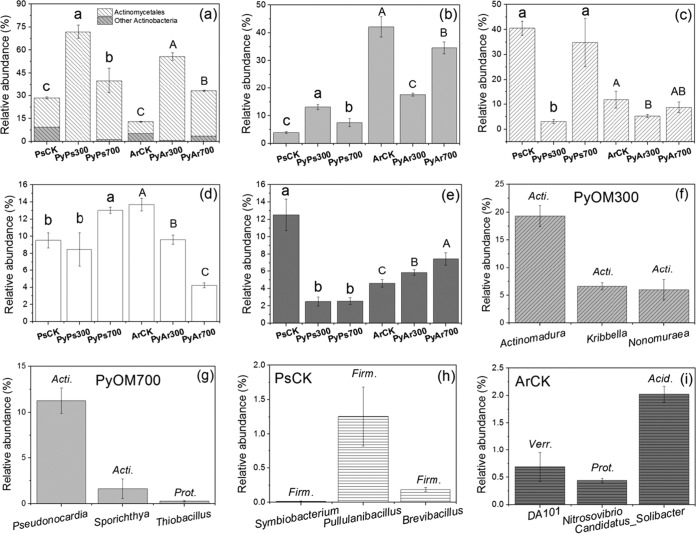
Relative abundances of dominant phyla in each treatment and indicator genera in PyOM300, PyOM700, and control soils. Values in Ps and Ar soil samples followed by the same lowercase and uppercase letter, respectively, are not significantly different at a P value of <0.05. (a) Actinobacteria. (b) Proteobacteria. (c) Chloroflexi. (d) Acidobacteria. (e) Firmicutes. (f) Indicator genera in PyOM300, regardless of soil type. (g) Indicator genera in PyOM700, regardless of soil type. (h) Indicator genera in PsCK. (i) Indicator genera in ArCK. Acti., Actinobacteria; Firm., Firmicutes; Prot., Proteobacteria; Acid., Acidobacteria; Verri., Verrucomicrobia.